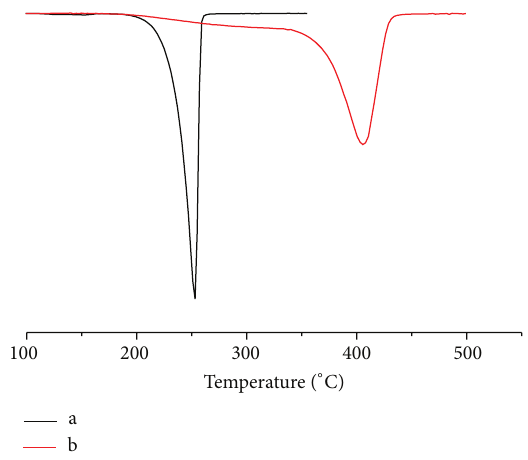
Figure 7: Typical stress-strain curves of PUHE with different